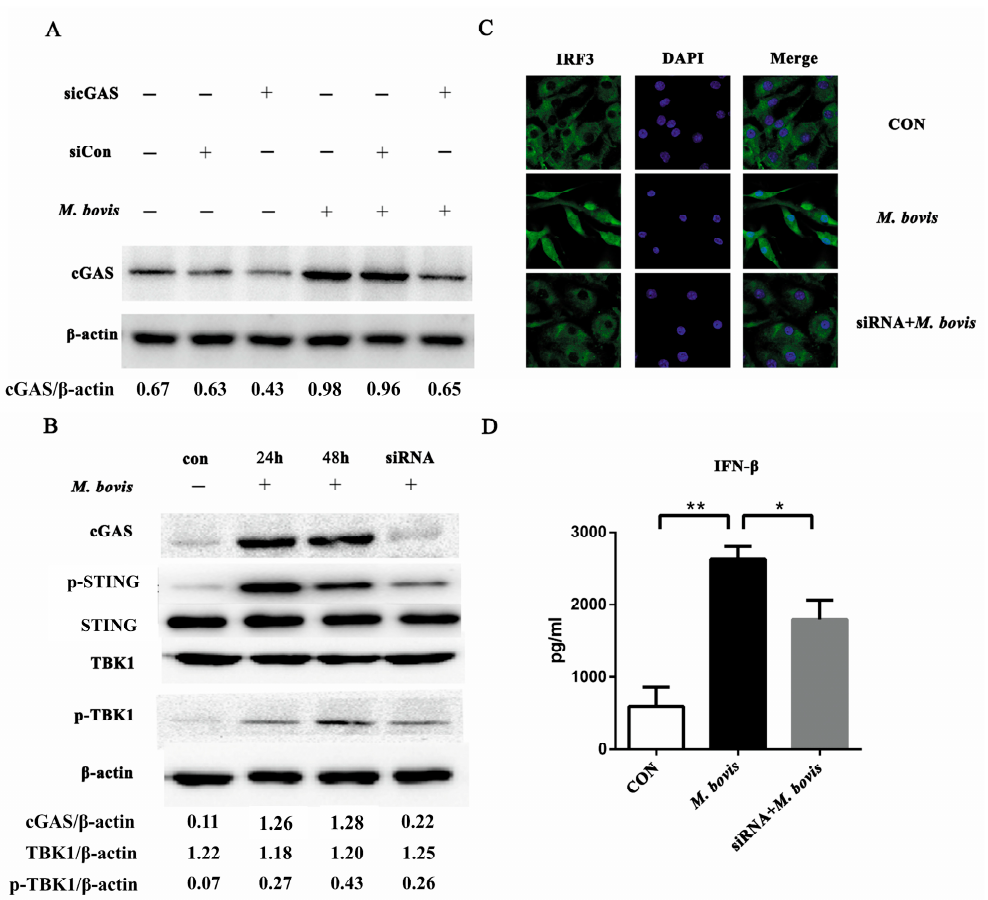
Figure 1. The cyclic GMP-AMP synthase (cGAS) pathway is activated in bone marrow-derived dendritic cells (BMDCs) during Mycobacterium bovis infection. ( A ) BMDCs were treated with siRNA, siCon, and M. bovis , and cGAS protein was analyzed by Western blotting at 24 h after treatment. ( B ) The related proteins in the cGAS pathway in BMDCs were assayed by Western blotting. The protein levels of cGAS, p-STING, STING, TBK1, and p-TBK1 were analyzed in BMDCs transfected with siCon or sicGAS and then infected for 24 or 48 h with M. bovis (MOI 5). ( C ) The co-localization of IRF3 within the nucleus was detected by immunofluorescence microscopy (400 × ). ( D ) The culture supernatants were harvested after 24 h and assessed by ELISA. All data are expressed as mean ± SD, (* p < 0.05; ** p < 0.01; n.s.: no statistical significance). IFN: interferon.